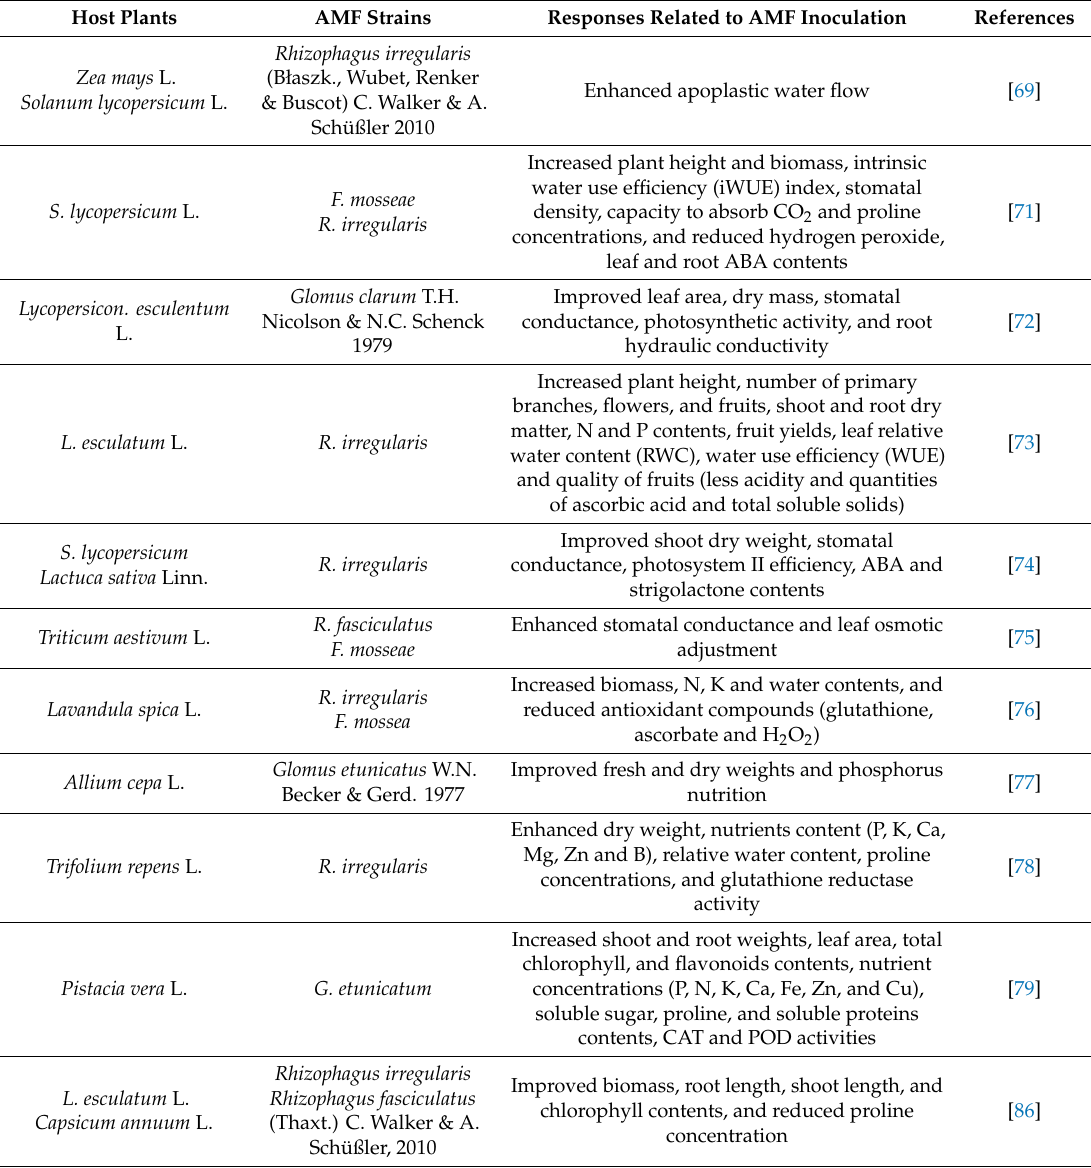
Table 1. Contribution of AMF in helping plants to cope with drought